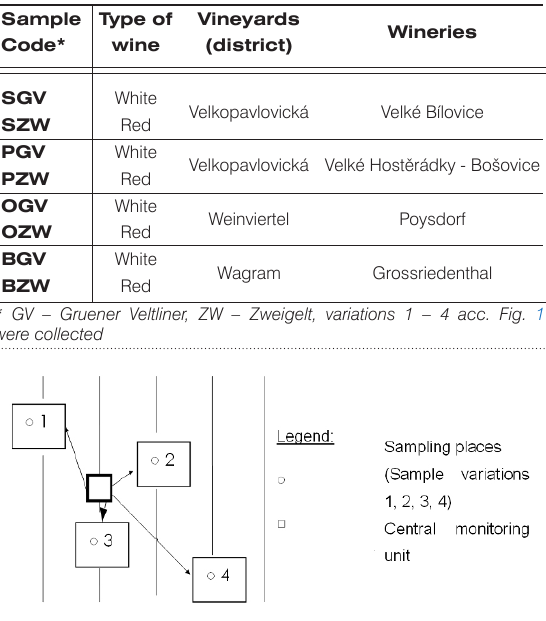
Figure 1. Plan of the experimental fields for sampling from individual experimental vineyards in Czech Republic (S, P) and Austria (O,